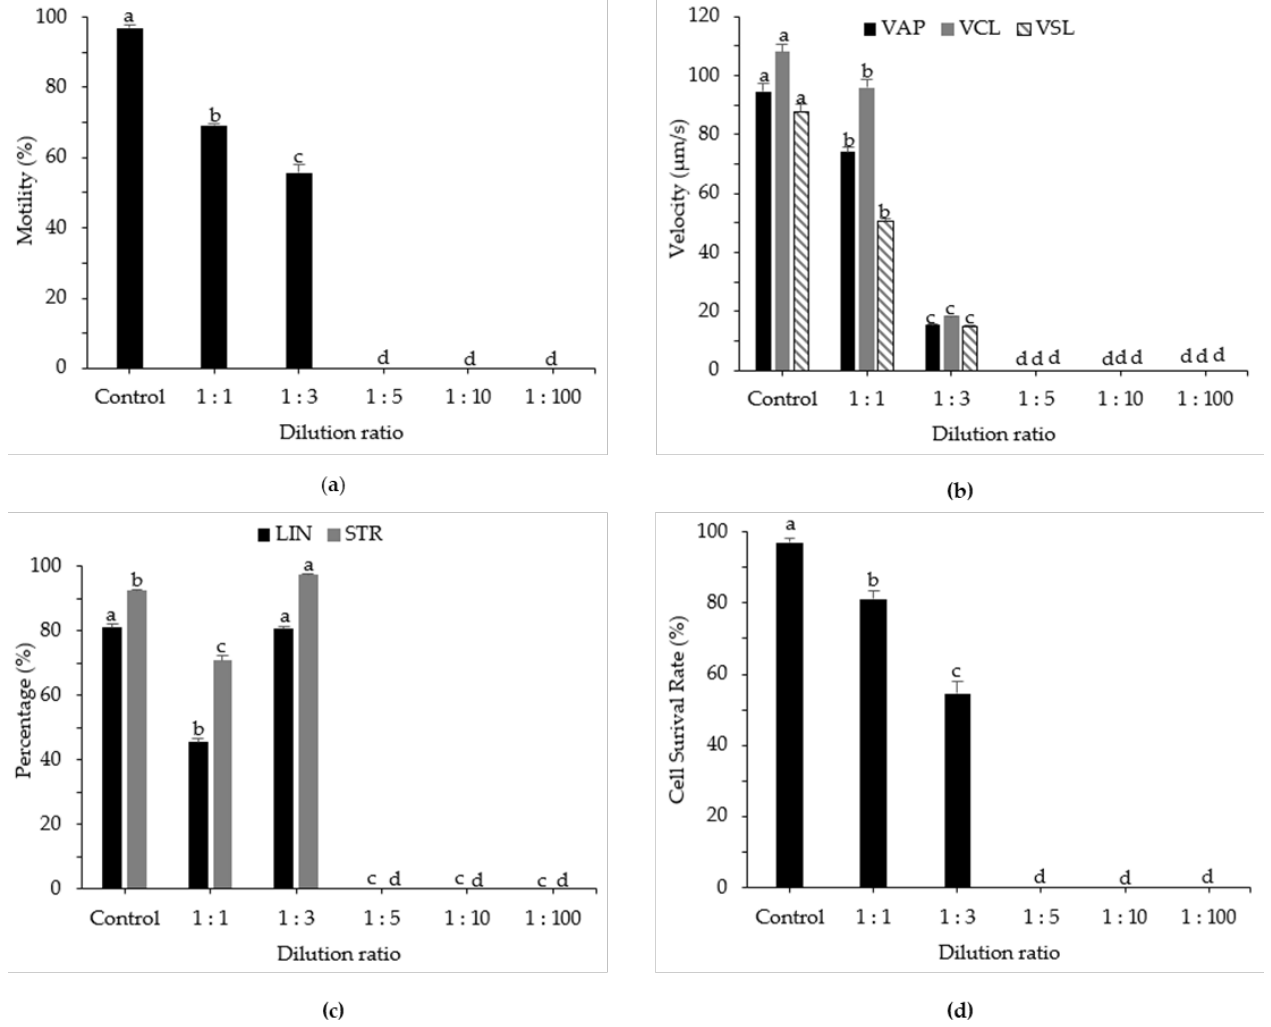
Figure 4. Computer-assisted sperm analysis of frozen and fresh sperm from roughscale sole, Clidoderma asperrimum , at various dilution ratios. ( a ) Motility (%), ( b ) average path velocity (VAP; µ m s − 1 ), curvilinear velocity (VCL; µ m s − 1 ), straight-line velocity (VSL; µ m s − 1 ), ( c ) linearity (LIN; %), straightness (STR; %), and ( d ) cell survival rate (%). Different lowercase letters indicate significant differences among dilution ratios ( p < 0.05). Control, fresh sperm.